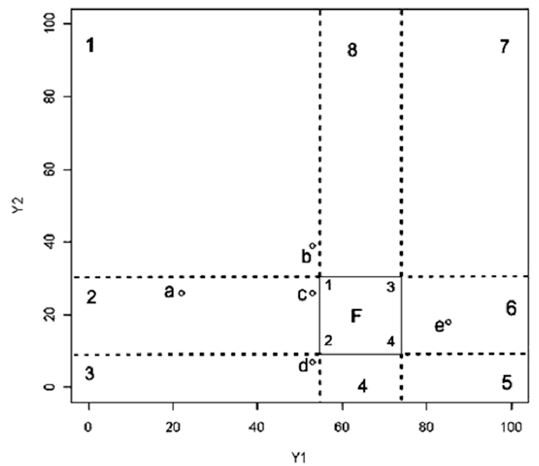
Figure 5. Space segmentation by stretching the sides of the effective zone (area F).